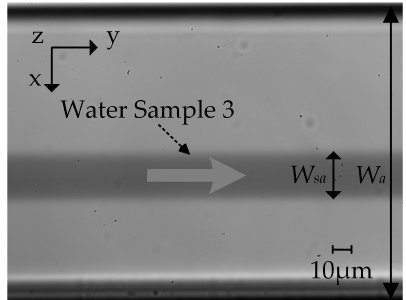
Figure 12. Images of sample 3 at the sheath flow rate of 25.5 µL/s and sample flow rate of 2.84 µL/s.